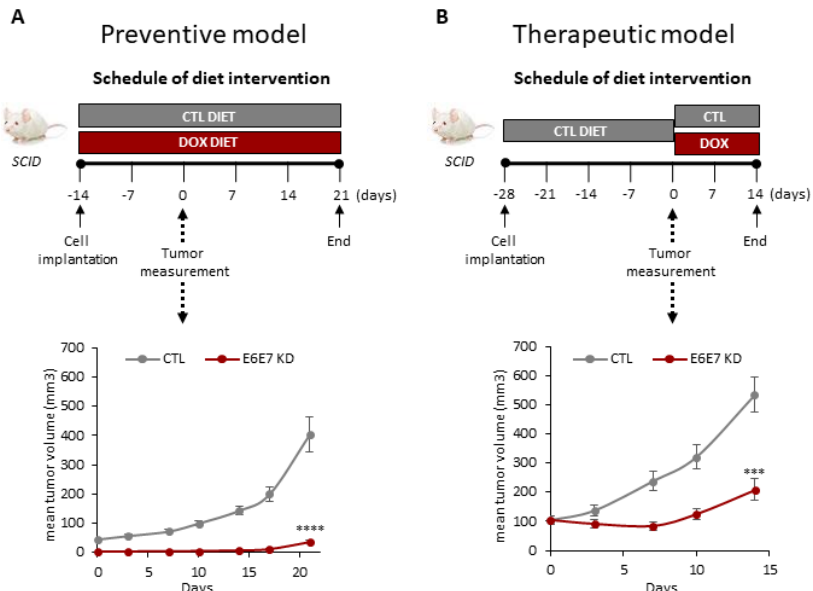
Figure 2. Inducible HPV16E6E7 knockdown inhibits the in vivo tumorigenicity of HPV16+ SCC. ( A ) Chemoprevention model. UMSCC47-shRNA4 (1 × 10 6 ) cells were implanted subcutaneously into the flanks of 7- to 8-week-old, female athymic nude mice and fed control diet or doxycycline-con- taining diet (200 mg/kg doxycycline hyclate) ad libitum. *** p < 0.001; **** p < 0.0001. ( B ) Therapeutic model. UMSCC47-shRNA4 (1 × 10 6 ) cells were implanted subcutaneously into the flanks of 7- to 8- week-old, female athymic nude mice and fed a control diet until the development of established tumors. Subsequently, animals were randomized to continue to receive the control diet or doxycy- cline-containing diet (200 mg/kg doxycycline hyclate) ad libitum. *** p < 0.001; **** p < 0.0001.